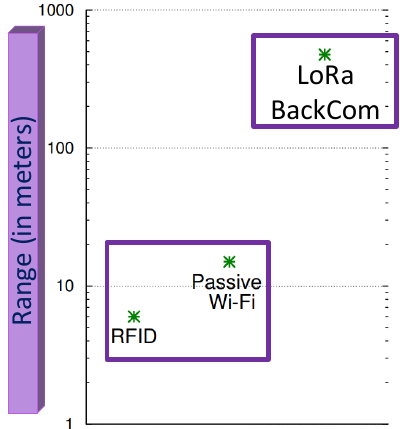
Figure 35. Increased range in the LoRa